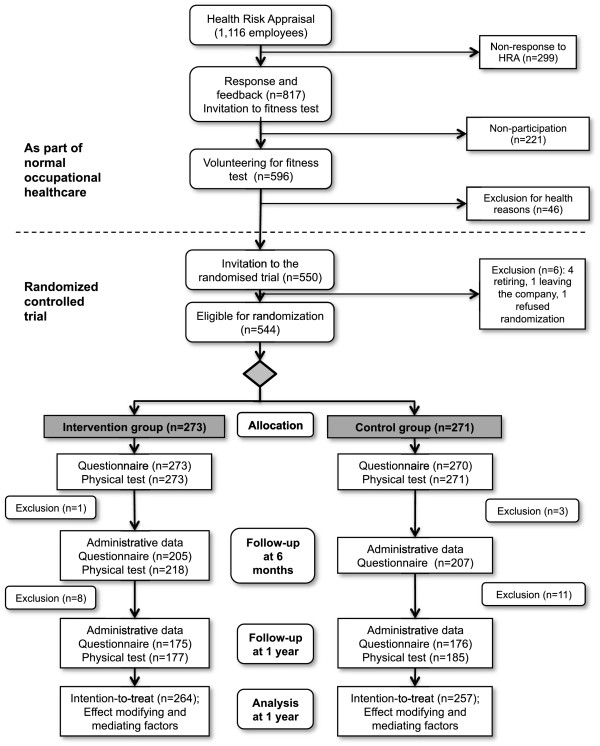
Participant flow.